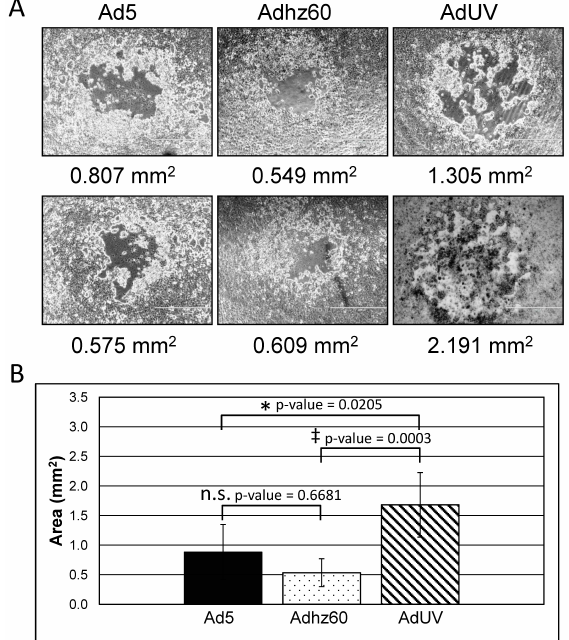
Figure 3. AdUV spread in A549 cells. ( A ) Two representative plaques of Ad5, Adhz60 and